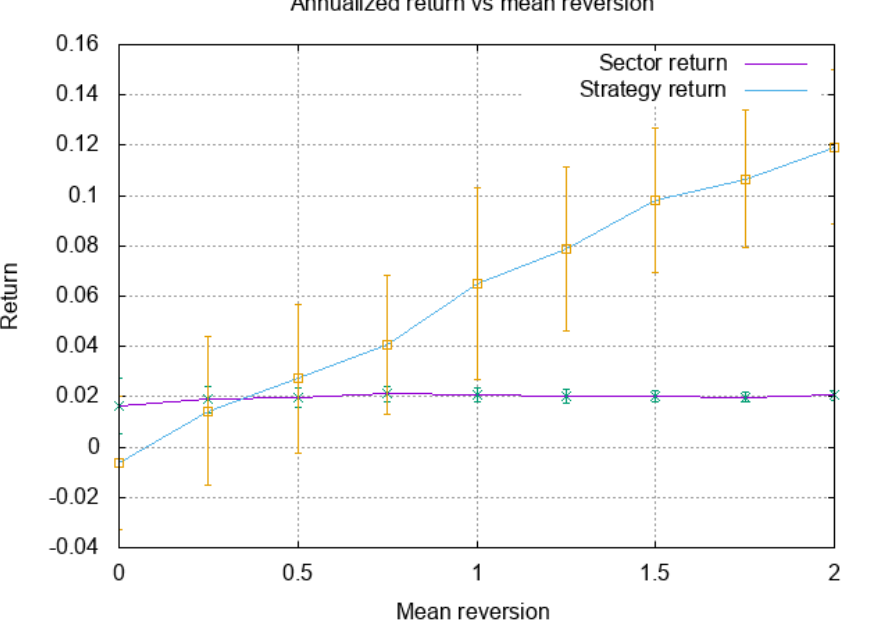
Figure 5. Reversals strategy performance as a function of mean reversion, 10 year horizon, 50 trials for each mean reversion. Error bars show standard deviation of